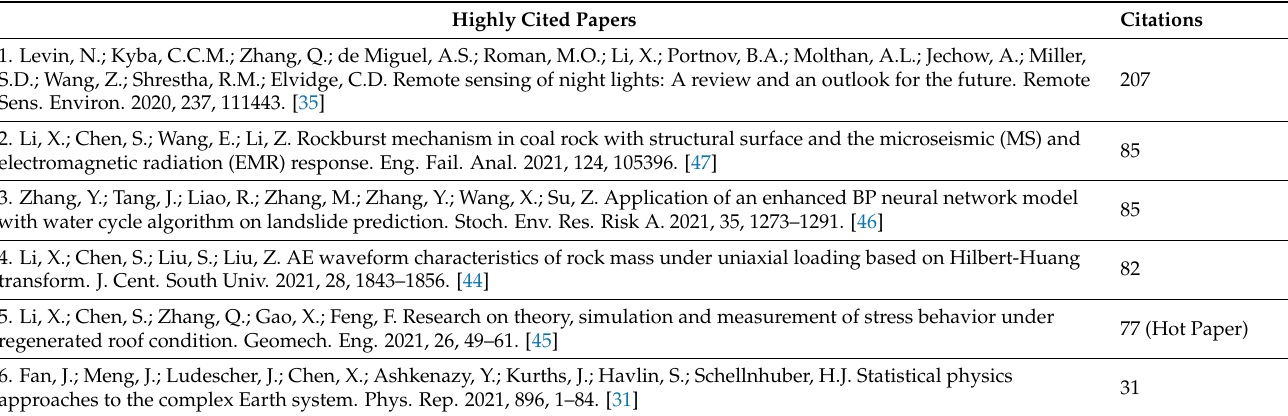
Table 1. The highly cited articles of China’s dynamic disaster monitoring and early warning inter- national research (2000–2021).